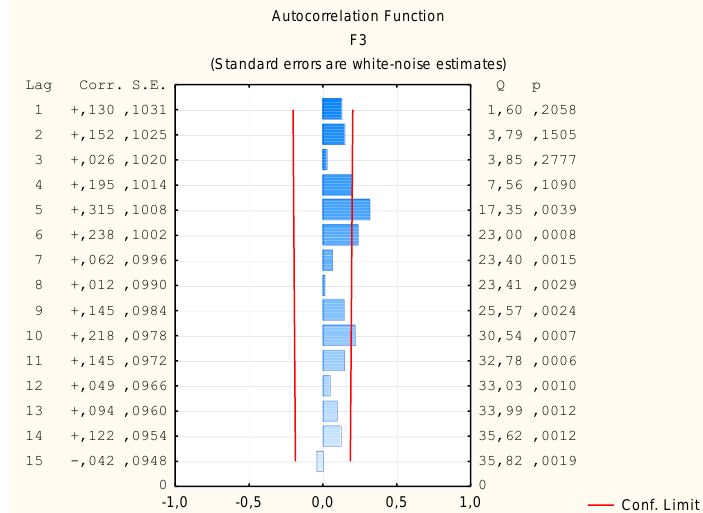
Fig. 11. Autocorrelation function of the 2-nd component.